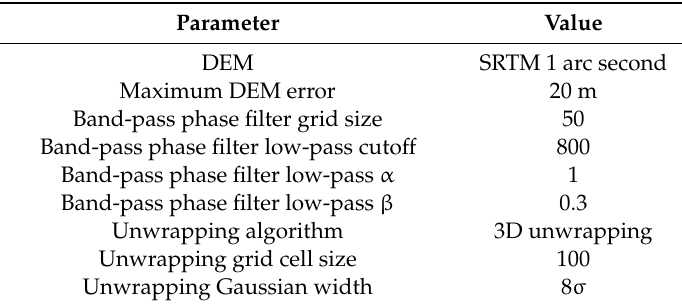
Table 2. The parameter in StaMPS